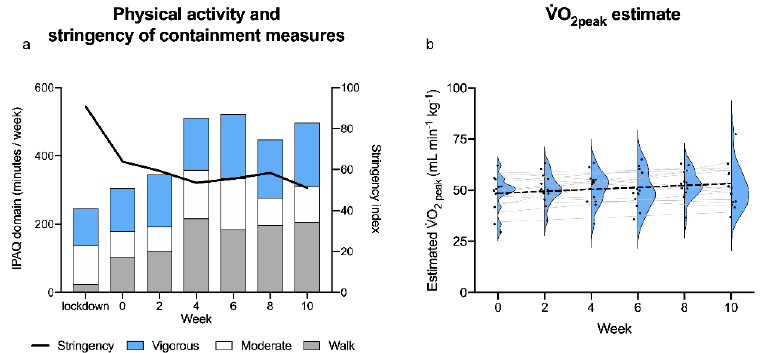
Figure 2. ( a ) Physical activity and stringency of containment measures. During the study period, the stringency of the COVID-19 containment measures fell (black line), while participants increased their total physical activity levels (bars: average time doing walking, moderate, or vigorous activity). ( b ) Estimated V̇ O 2peak throughout the follow-up. The estimated V̇ O 2peak increased by ∼ 0.7%/week (t-statistic: 1.3); individual data points, individual and mean regression lines (thin and thick, respectively), and probability density functions (violin contours) are reported.